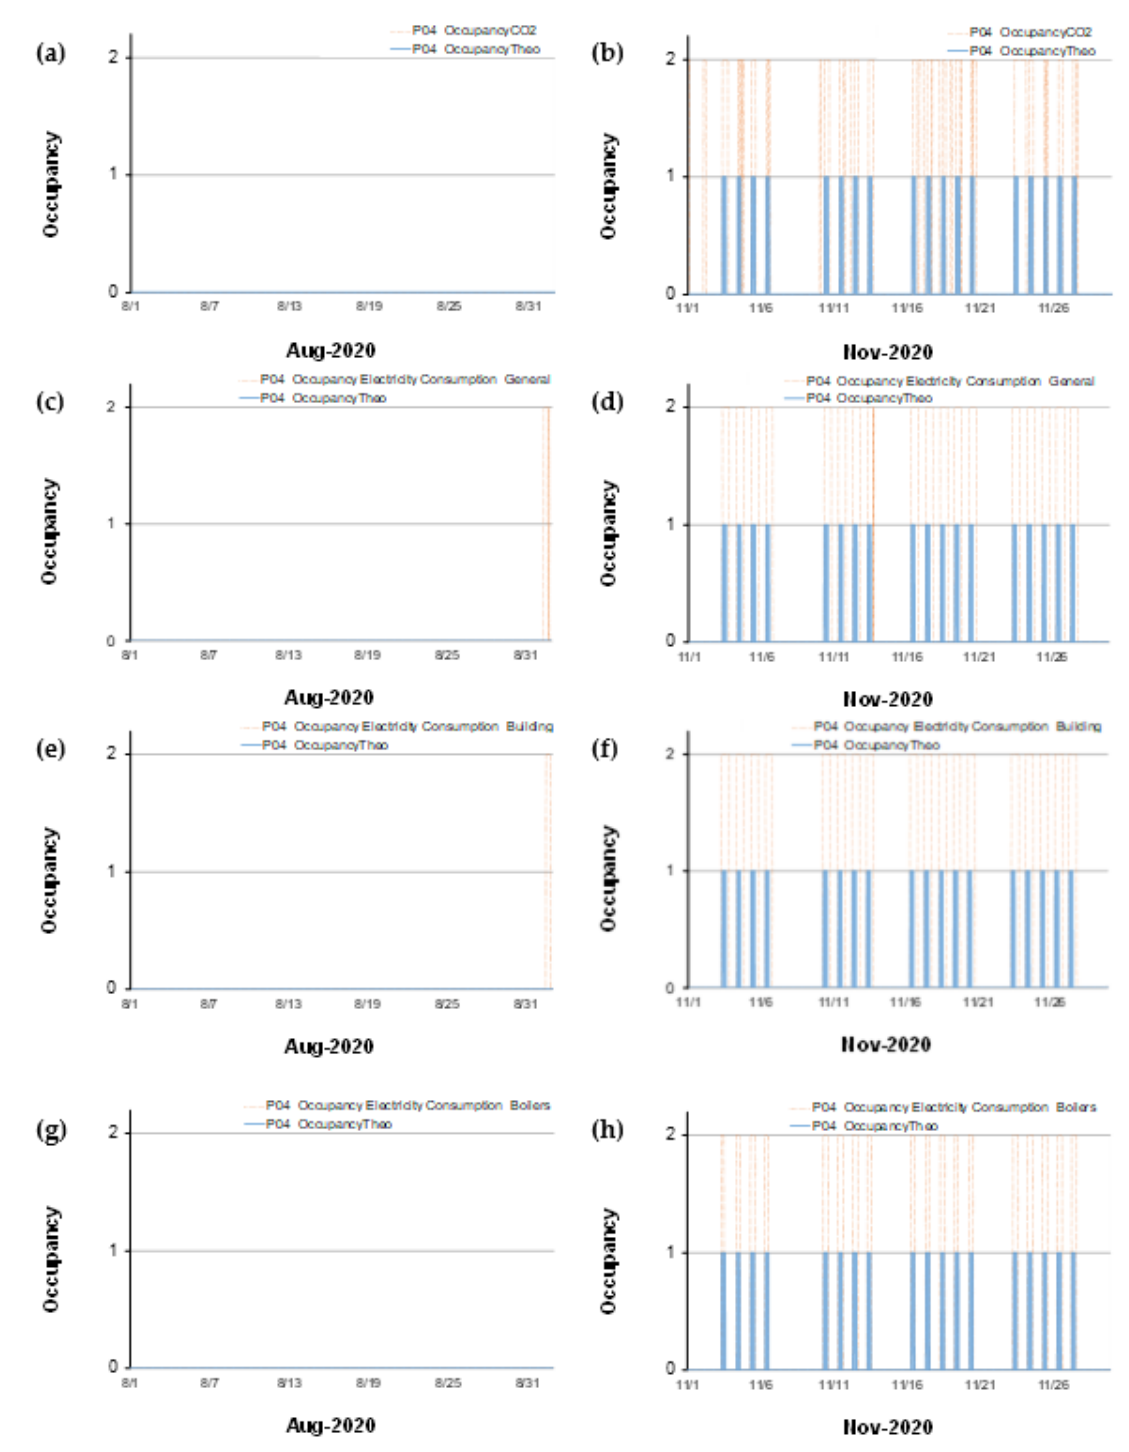
(blue bars) vs. theoretical occupancy (orange bars), with ( a , c , e , g ) data from vacation vs. ( b , d , f , h ) data Figure 6. Monthly occupancy classroom patterns obtained from the assessed candidate variables (blue bars) vs theoretical from the scholar occupancy (orange bars), with ( a ), ( c ), ( e ), ( g ) data from vacation vs ( b ), ( d ), ( f ), ( h ) data from the scholar period.